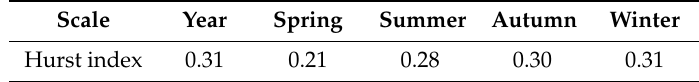
Table 2. The Hurst index of the ET 0 series for the year and four